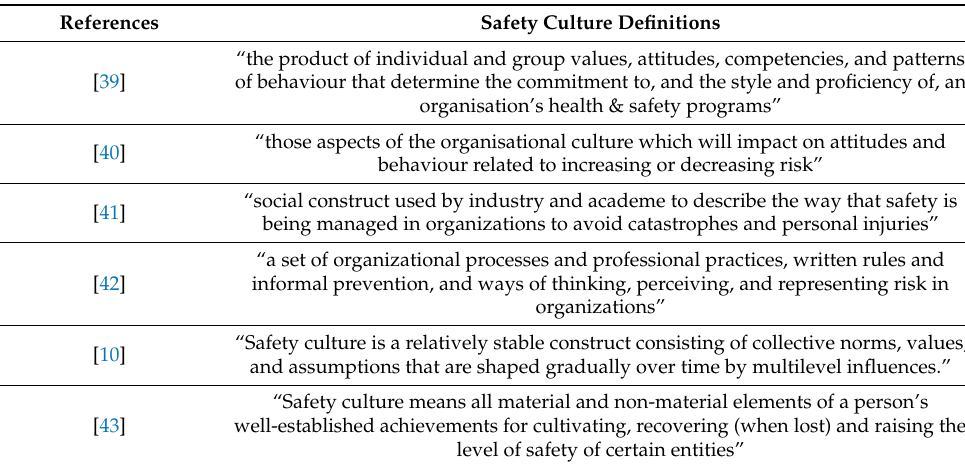
Table 1. Examples of safety culture